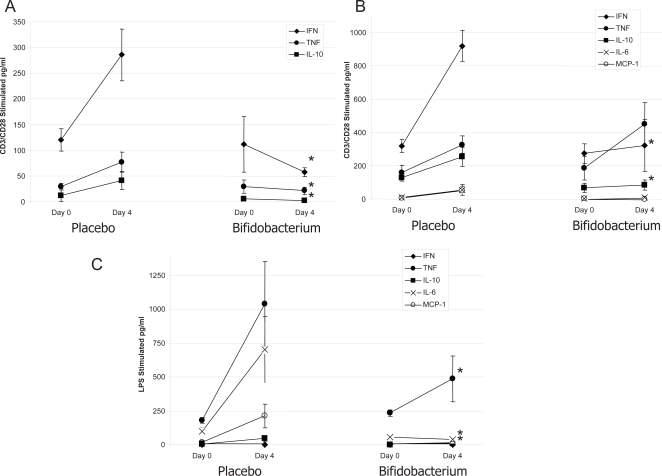
Cytokine production is suppressed in S. typhimurium-infected mice when pre-treated with B. infantis.Cytokine release by isolated cells was examined immediately prior to S. typhimurium infection (Day 0) or four days (Day 4) after infection. (A) In vitro cytokine production by anti-CD3/CD28 stimulated Peyer's patch cells is significantly reduced in S. typhimurium infected mice when fed B. infantis with no differences being observed prior to infection; (B) In vitro IFN-γ and IL-10 production by anti-CD3/CD28 stimulated spleenocytes is significantly increased in placebo-fed animals following S. typhimurium infection. However, this increase was not observed in animals consuming B. infantis. TNF-α levels were similar for the two groups; (C) LPS stimulated splenocytes released comparable amounts of cytokine from the two groups of animals prior to infection but four days following Salmonella translocation, LPS stimulated TNF-α, IL-6 and MCP-1 release was significantly less in the B. infantis-fed animals. *p<0.05 versus placebo, n = 8/group at each timepoint.